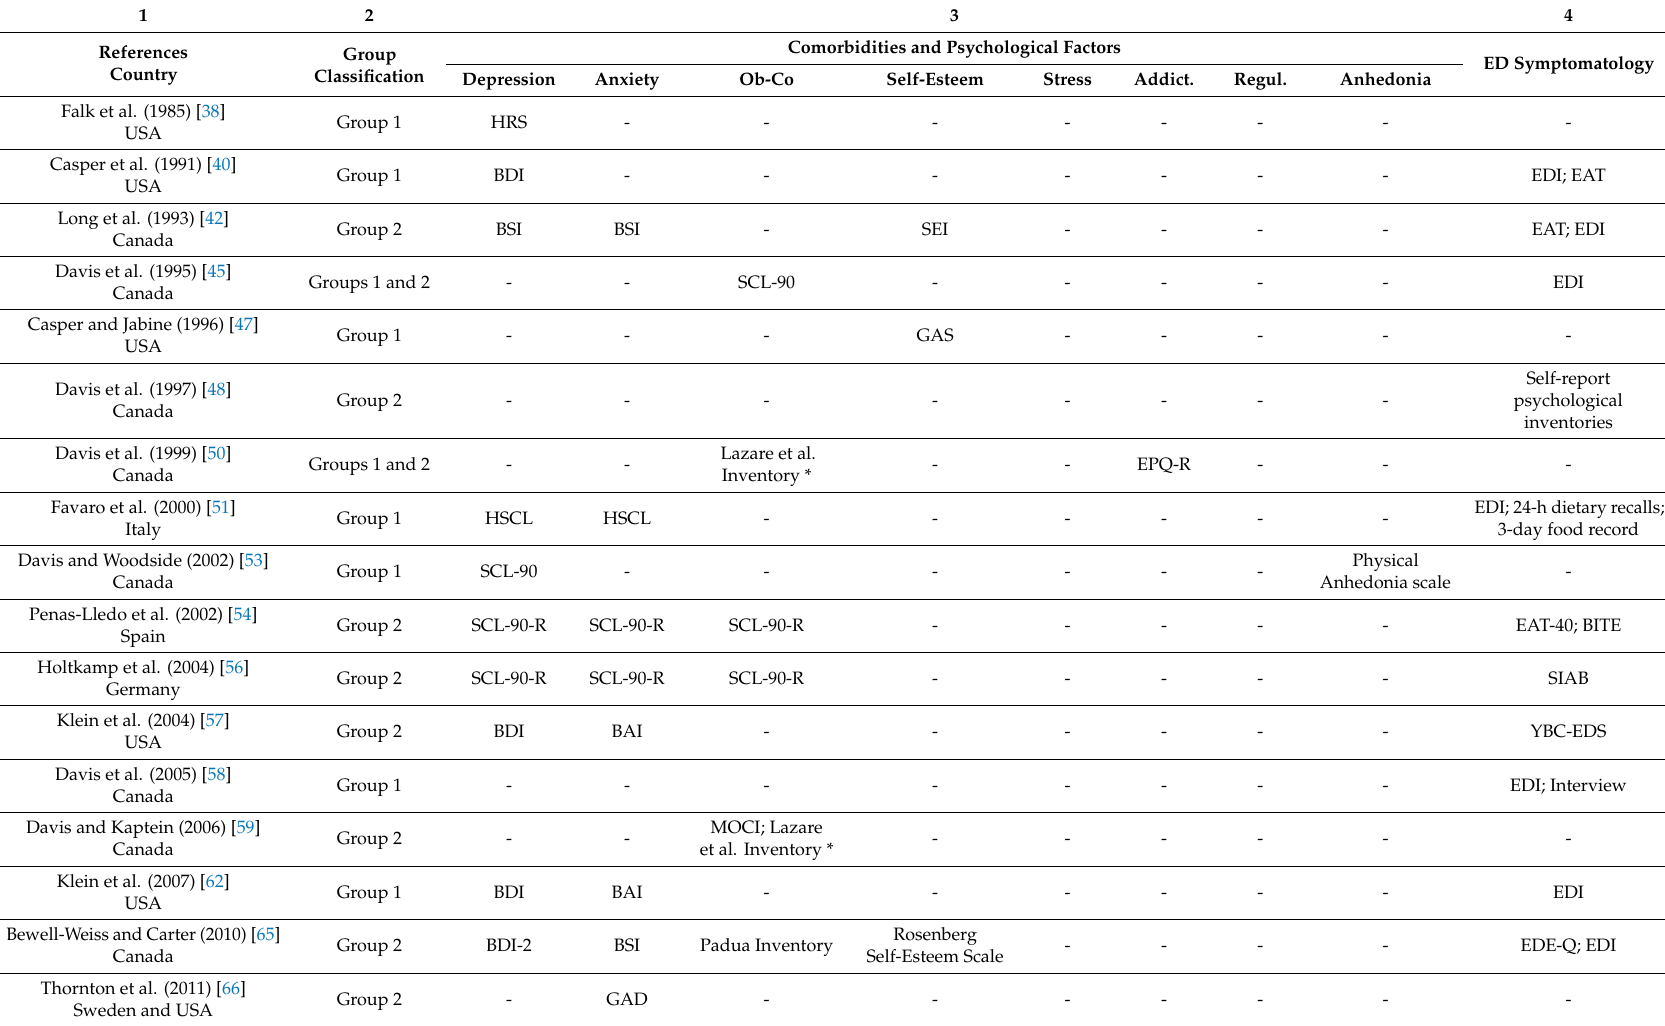
Table 4. Instruments used to assess comorbidities, psychological factors, and ED symptomatology (Columns 1 to